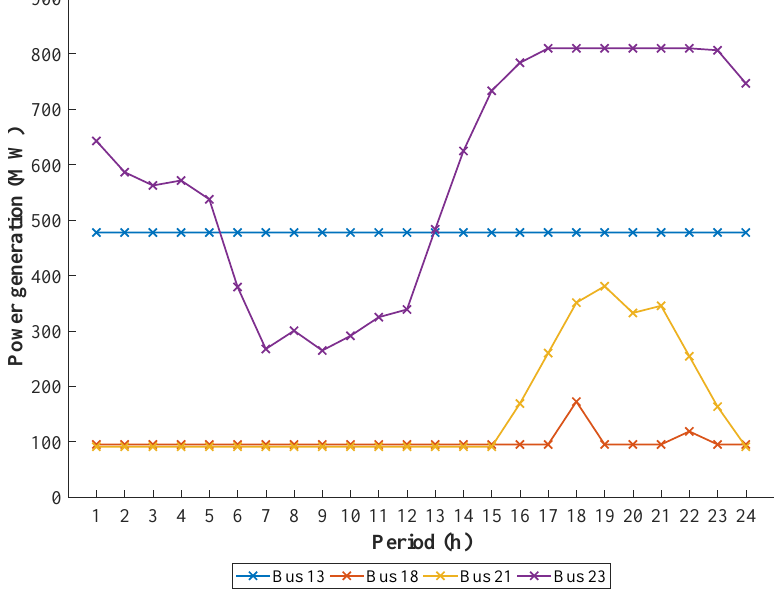
Figure 12. Hydro and thermal power generation values in Case 2. Table 6. Variation of the hydro and thermal power generation between Case 1 and Case 2, on average. Bus 13 18 21 23 Variation (MWh) −